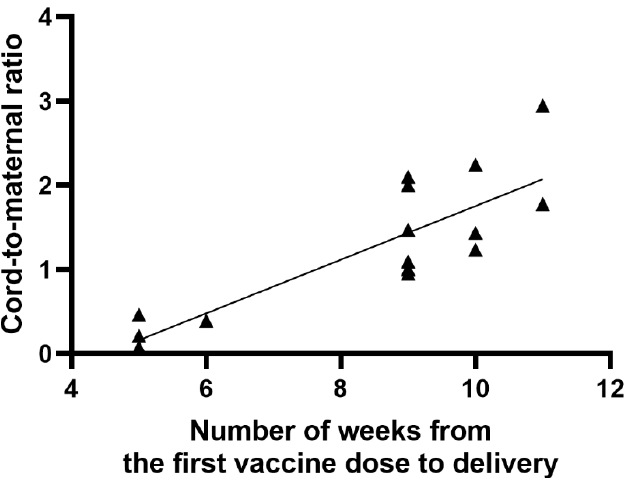
Figure 4. Correlation between the period (weeks) from the first vaccine dose to delivery and cord-to- maternal anti-S titer